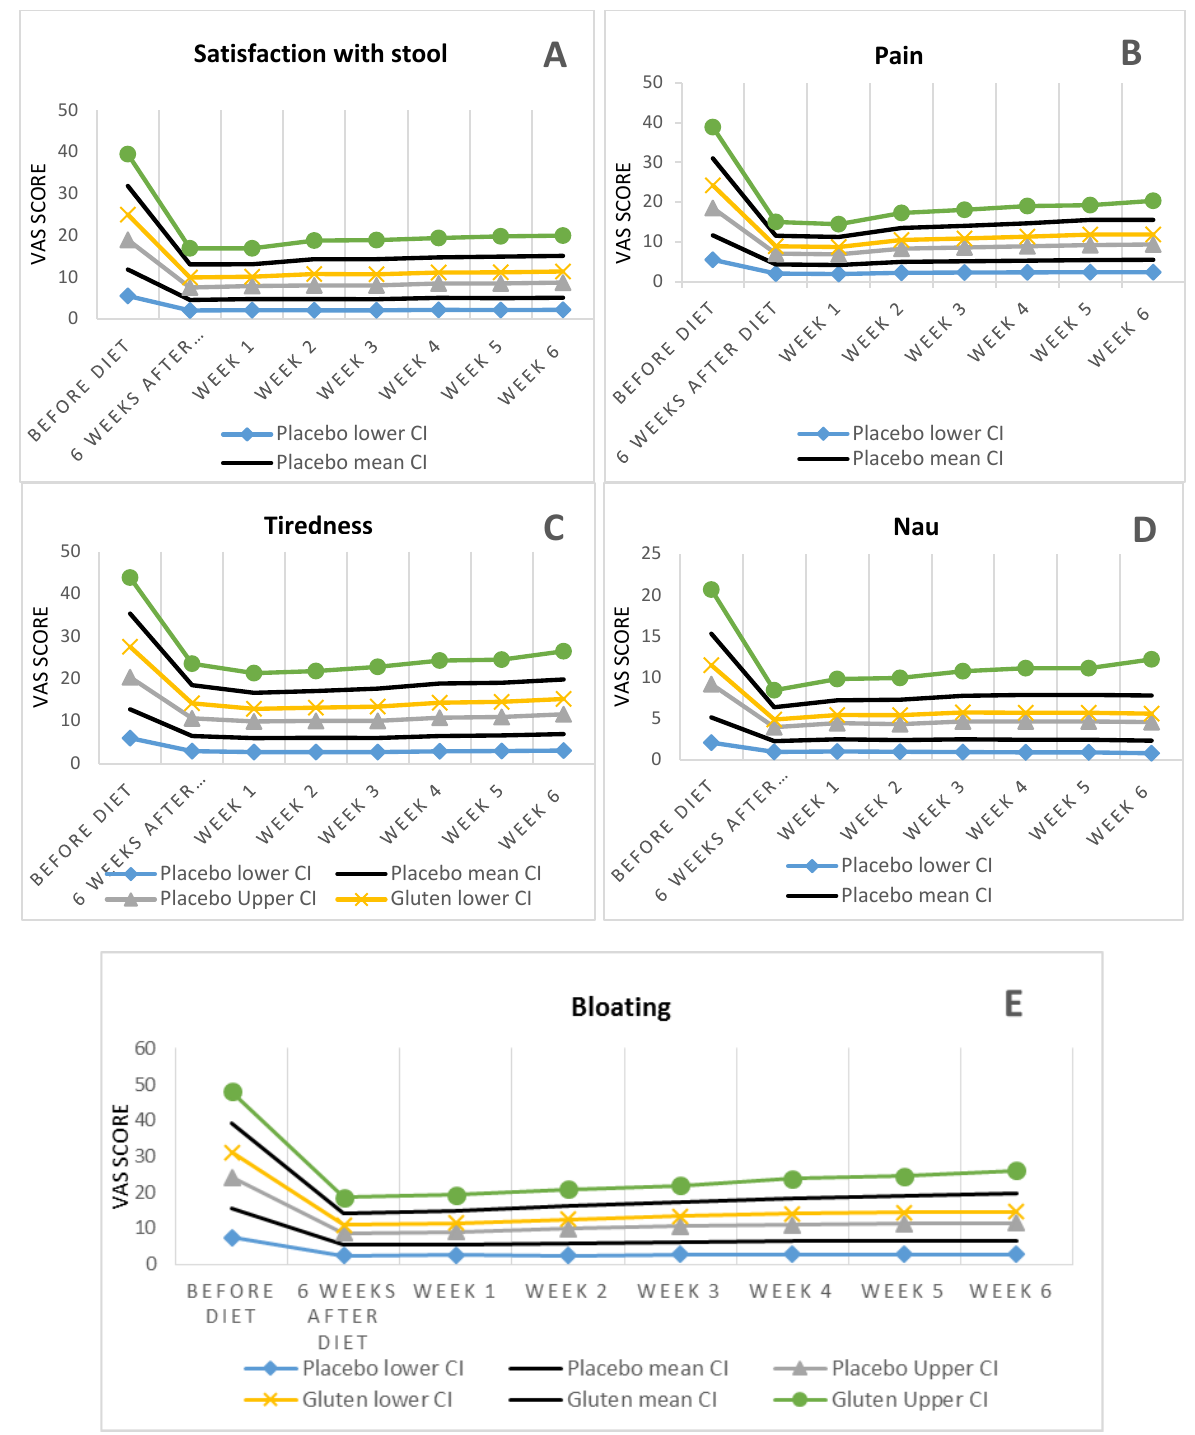
Figure 2. The difference between gluten and placebo groups in the pattern of symptoms. ( A ) Satisfaction with stool consistency; ( B ) Pain; ( C ) Tiredness; ( D ) Nausea; ( E ) Bloating. After six weeks of the diet, symptoms were controlled only in nine patients (25.7%) in the gluten-containing group, compared to 31 patients (83.8%) in the placebo group, indicating that 26 out of 35 patients in the gluten group became symptomatic on gluten-challenge. Comparison of these ratios indicated that there were significant differences between gluten-containing and placebo group symptoms control ( p < 0.001). In the gluten-containing group, all symptoms significantly increased especially